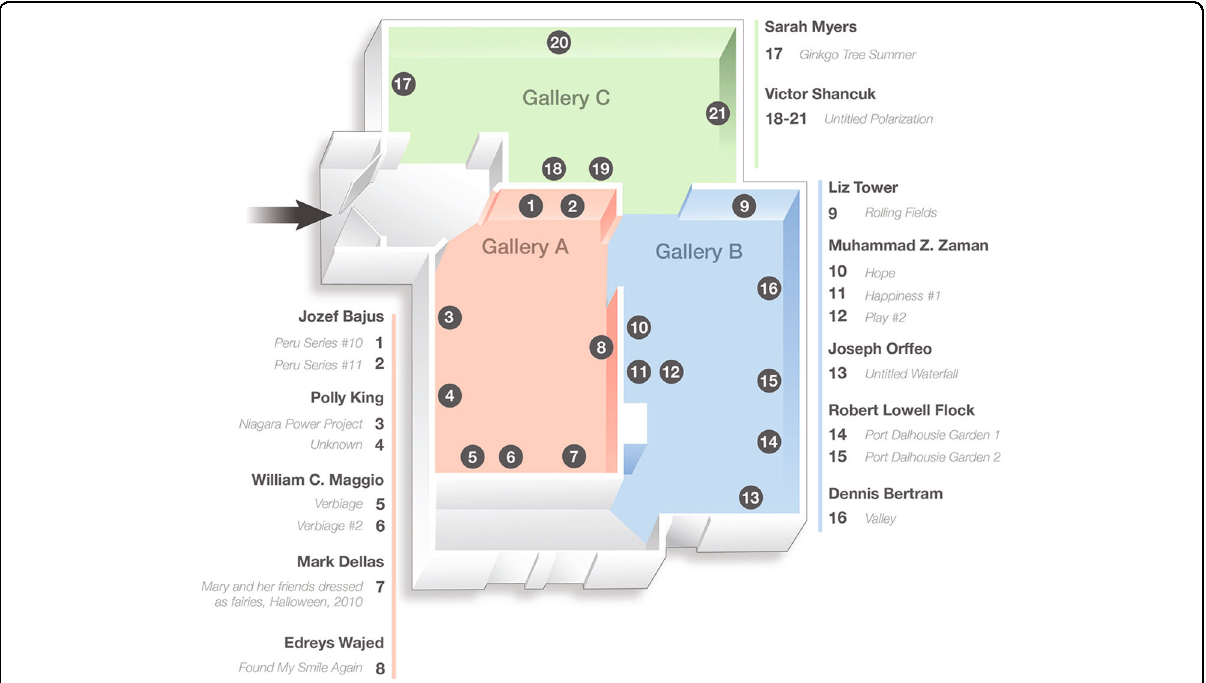
Fig. 1 Art gallery layout and artwork. Gallery A includes ‘ abstract ’ art types. Gallery B includes ‘ fi guration ’ art types, and gallery C includes ‘ landscape ’ art